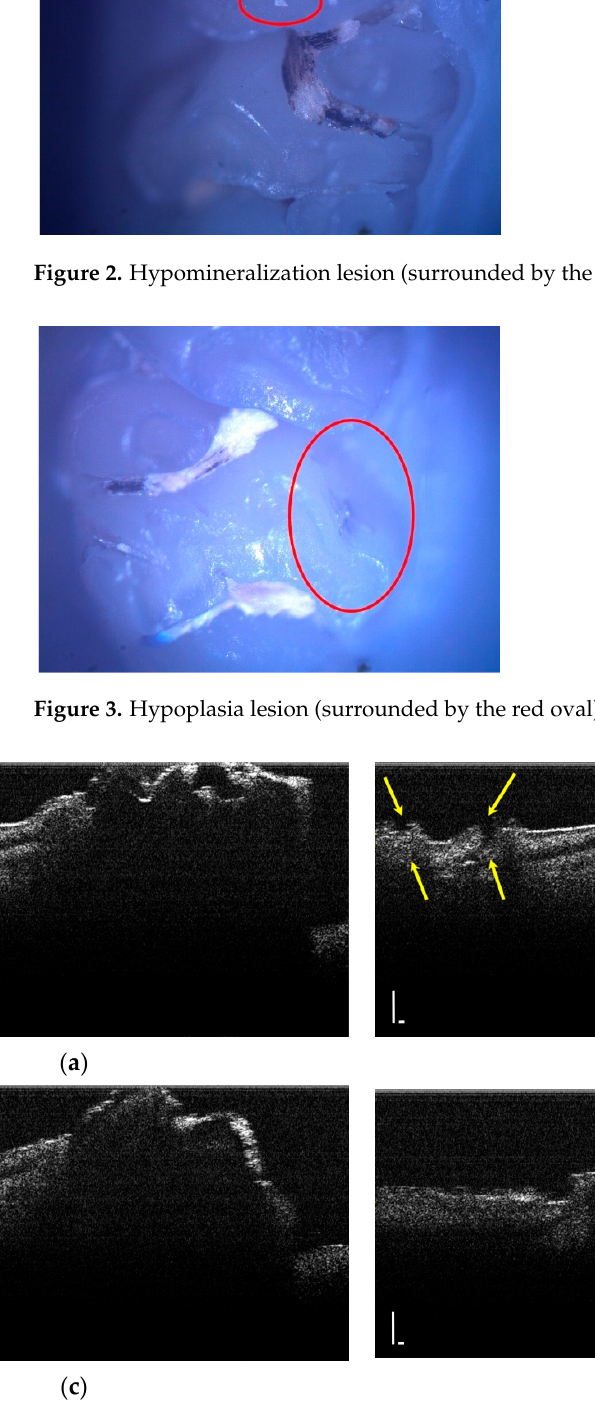
Figure 4. Two-dimensional OCT images of a tooth with hypomineralization (areas marked by yellow arrows): ( a ) cusp presenting a hypomineralization area; ( b ) extended area of hypomineralization, divided by a bridge of healthy enamel; ( c ) small-size hypomineralization area; ( d ) cusp presenting a hypomineralization area (scale bar 100 µ